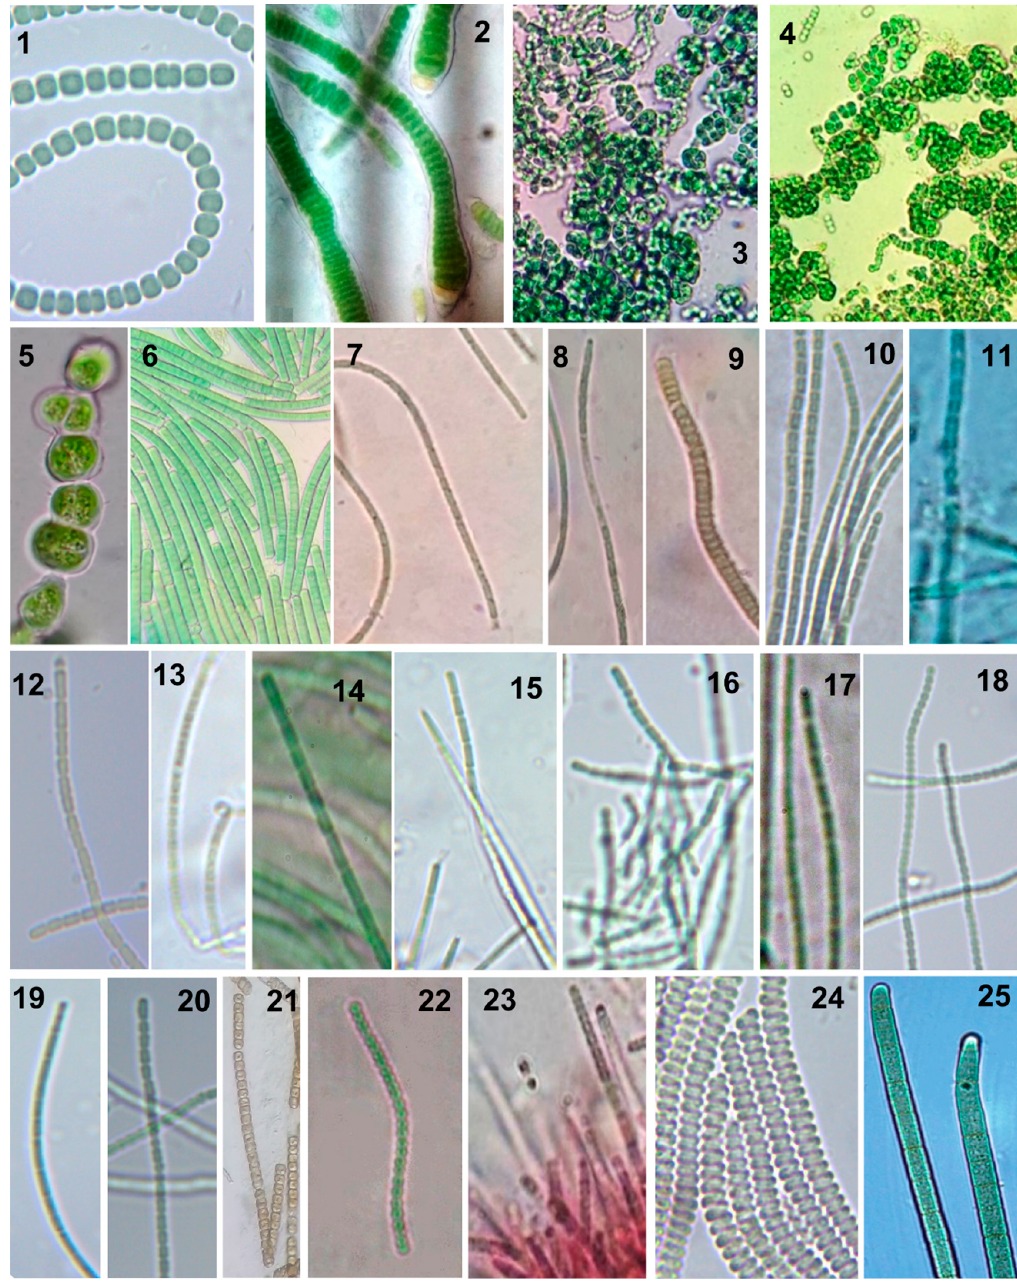
Figure 2. Photomicrographs showing morphological variations of marine cyanobacteria. 1, Anabaena variabilis SABC011501; 2, Calothrix contarenii SABC022701; 3, Chlorogloea microcystoides SABC011701; 4, Chlorogloea microcystoides SABC022904; 5, Hyella gigas SABC011201; 6, Kamptonema okenii SABC011902;